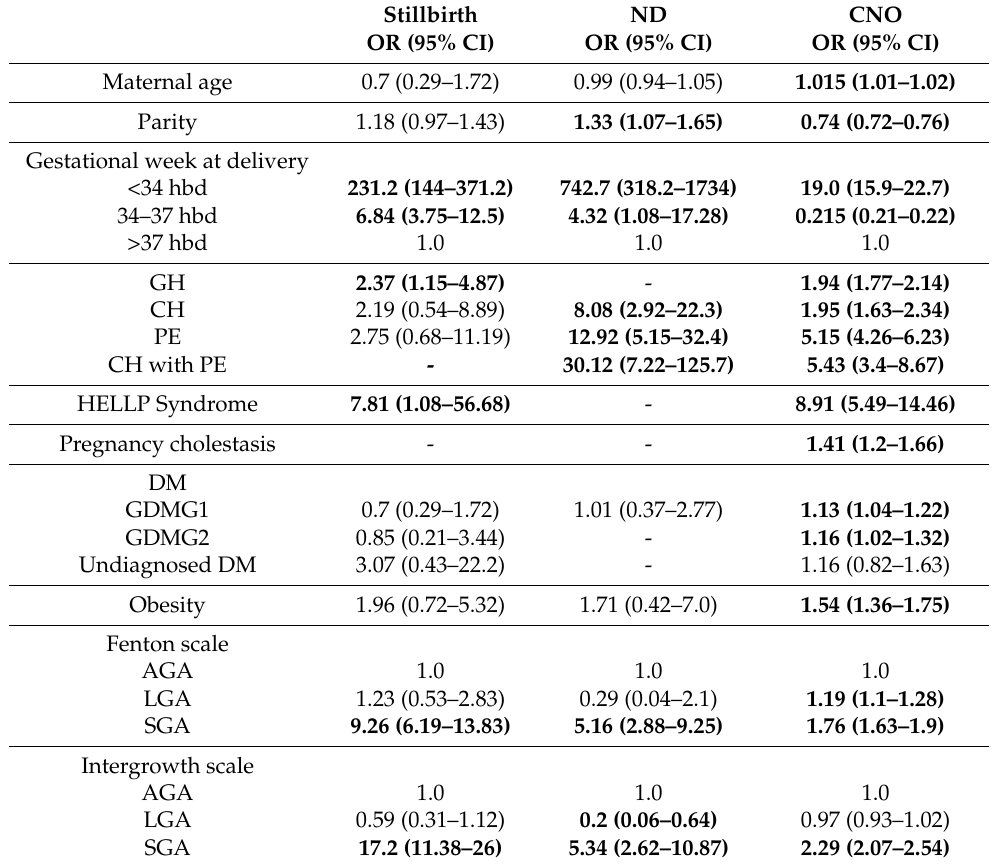
Table 4. Logistic regression for neonatal